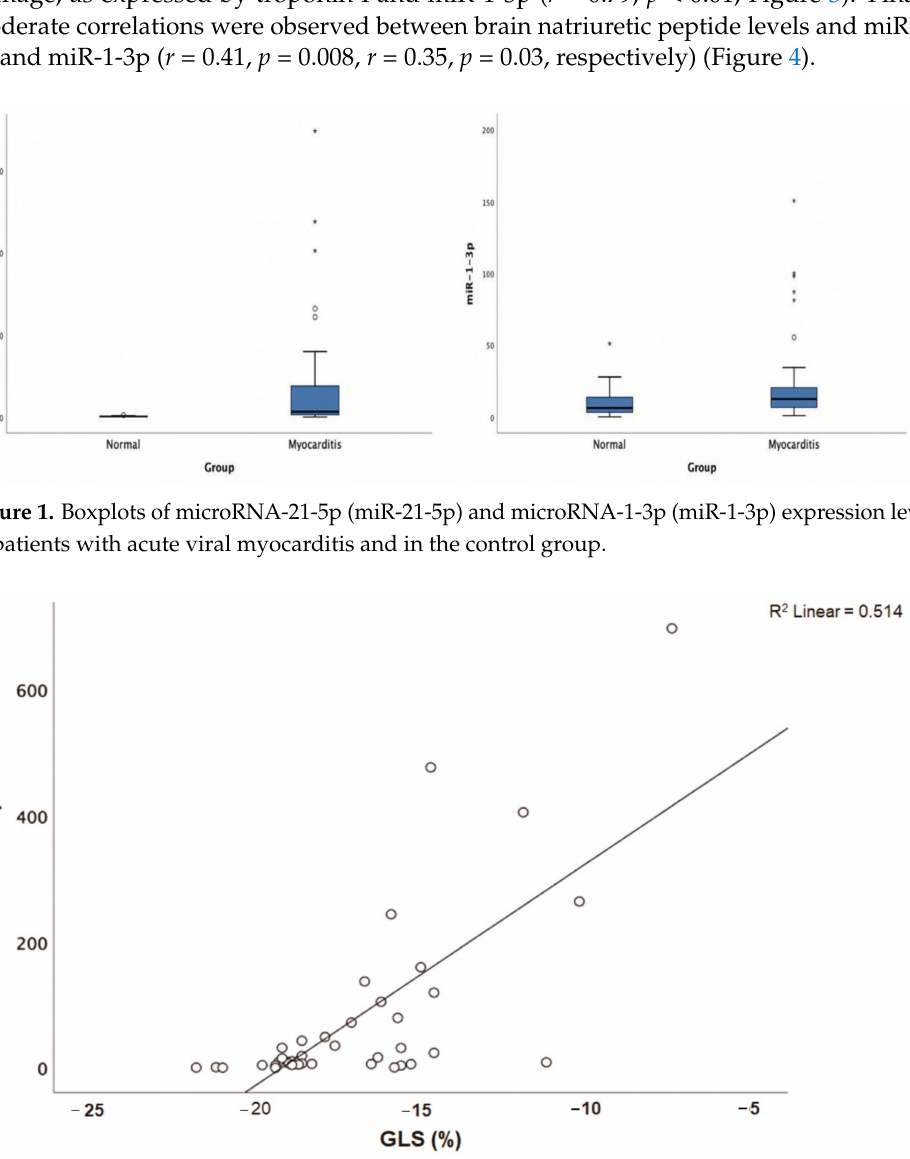
Figure 2. Correlation between global longitudinal strain (GLS, %) and microRNA-21-5p (miR-21- 5p) expression levels (arbitrary units calculated by the (2 − ddCt ) method) in patients with acute myocarditis ( r = 0.71, p <